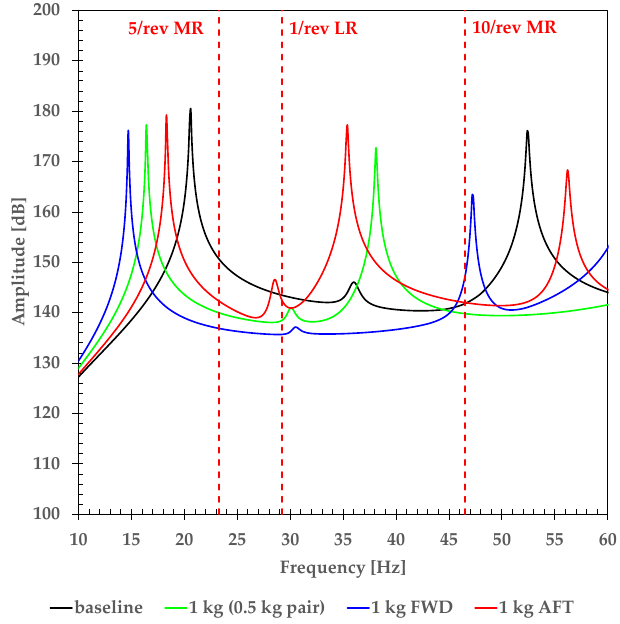
Figure 12. Extra-mass addition on an MLG door.